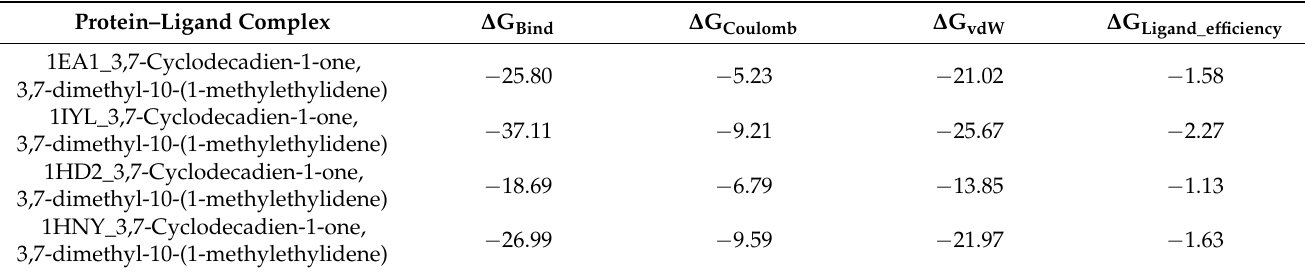
Table 6. MM/GBSA profiles of 3,7-cyclodecadien-1-one while interacting with target proteins. Protein–Ligand Complex